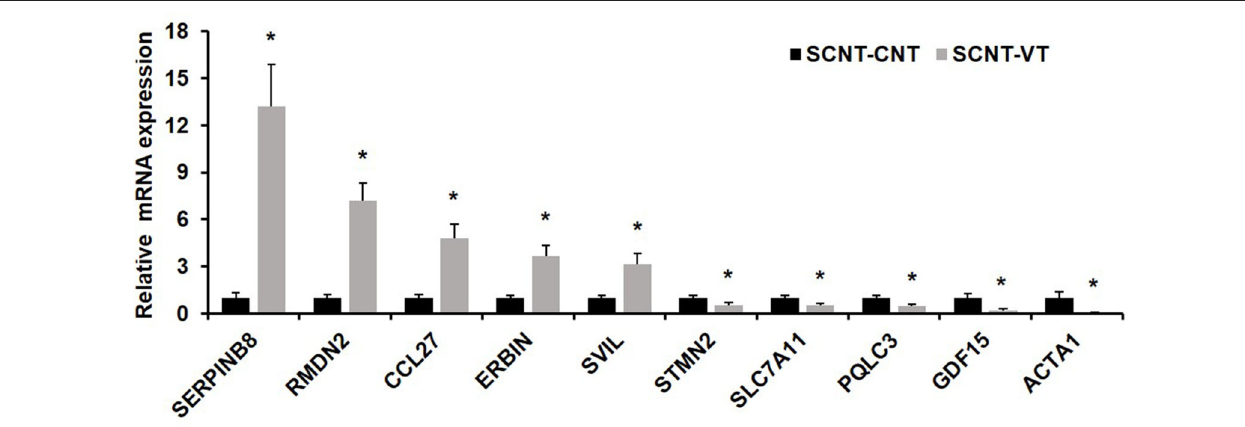
FIGURE 5 | Quantitative real-time PCR (qRT-PCR) of randomly selected differentially expressed genes (DEGs). Ten randomly selected DEGs were chosen and expression levels were validated using qRT-PCR. In response to the vitrification procedure, five genes were significantly upregulated ( SERPINB8, RMDN2, CCL27, ERBIN, SVIL ) and five were significantly downregulated ( STMN2, SLC7A11, PQLC3, GDF15, ACTA1 ). EF1 α 1 was used as the housekeeping gene. Values represent mean ± standard error of mean, and *indicates significant differences ( p <